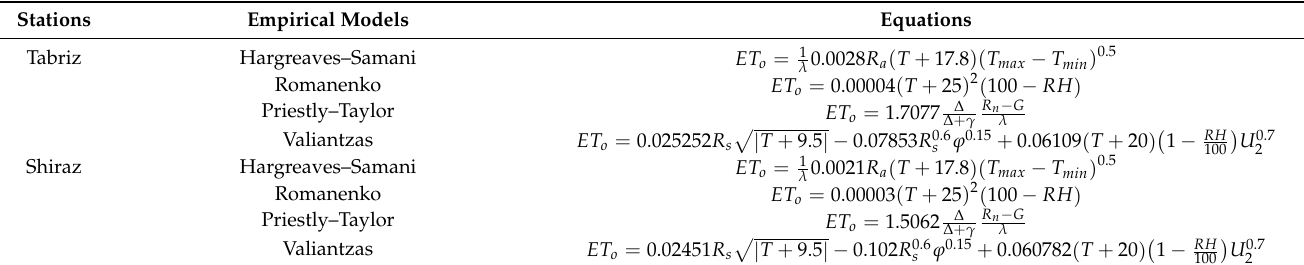
Table 9. The calibrated forms of empirical models applied in this